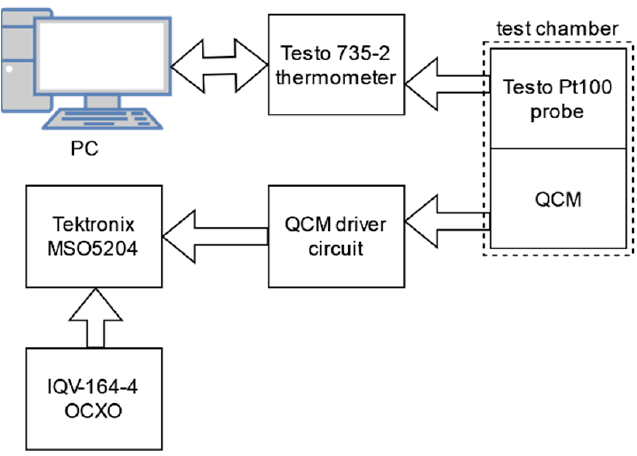
Figure 7. Measurement setup block diagram.